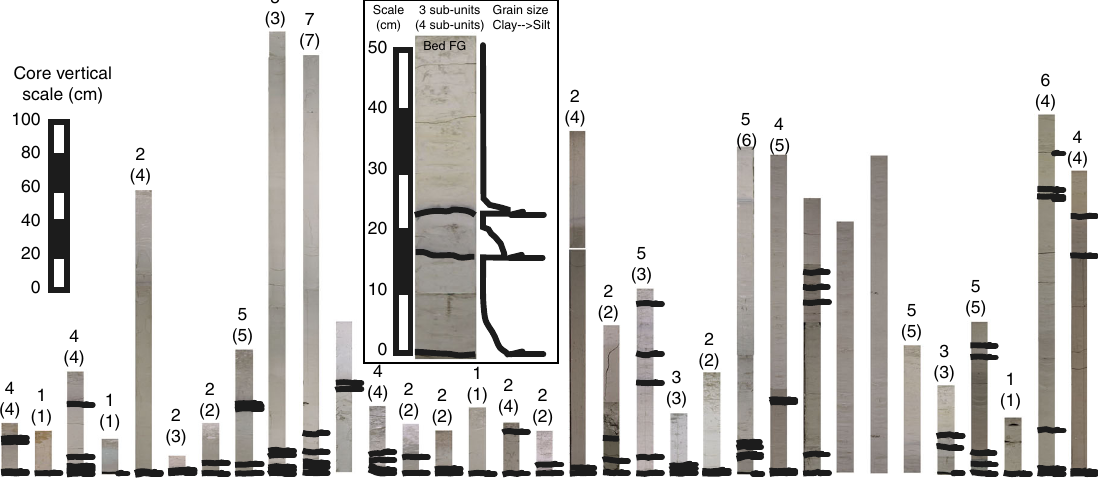
Fig. 8 Summary of pale-grey non-volcanic turbidites in ODP Core 950 greater than 10 cm thick showing presence or absence of subunits. Base of sub-units highlighted on the turbidite photographs (black lines parallel to base). Number of sub-units present in the bed in ODP Site 950 is given above the maximum number of sub-units in brackets from the same bed in ODP Sites 951 and 952. Inset shows a close-up exemplar photograph of Bed FG with a corresponding grain-size pro fi le. Sub-unit bases are